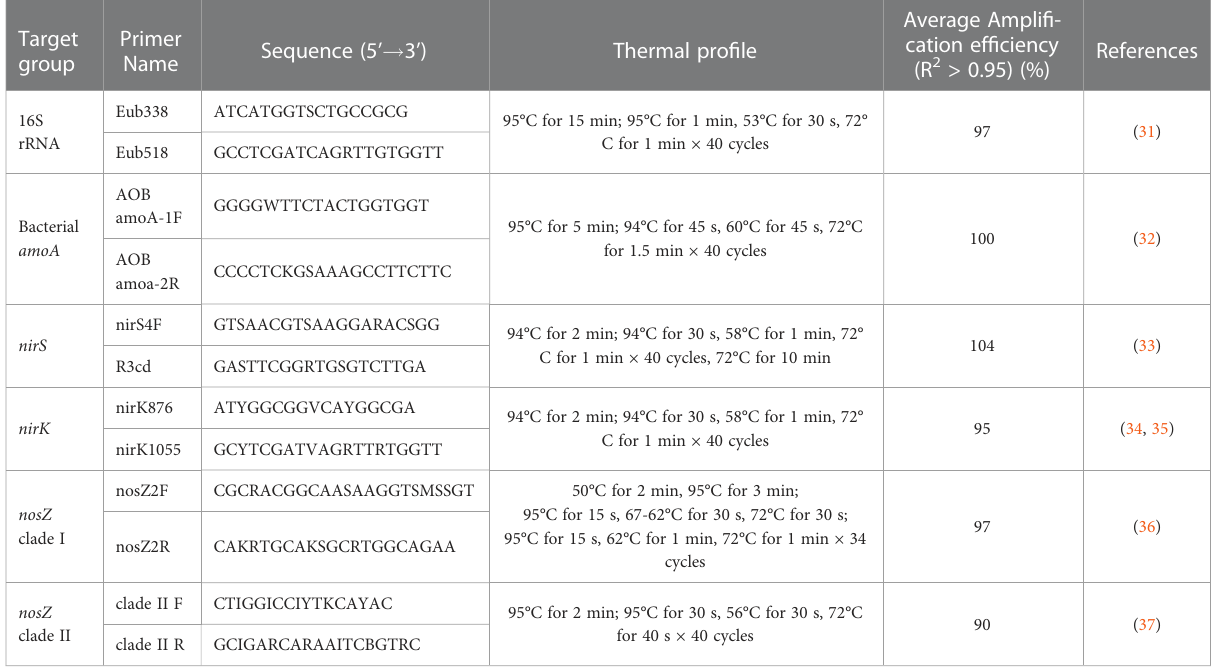
TABLE 1 Primer sequences and thermal pro fi les for total bacterial and bacterial N-cycle functional gene abundances.